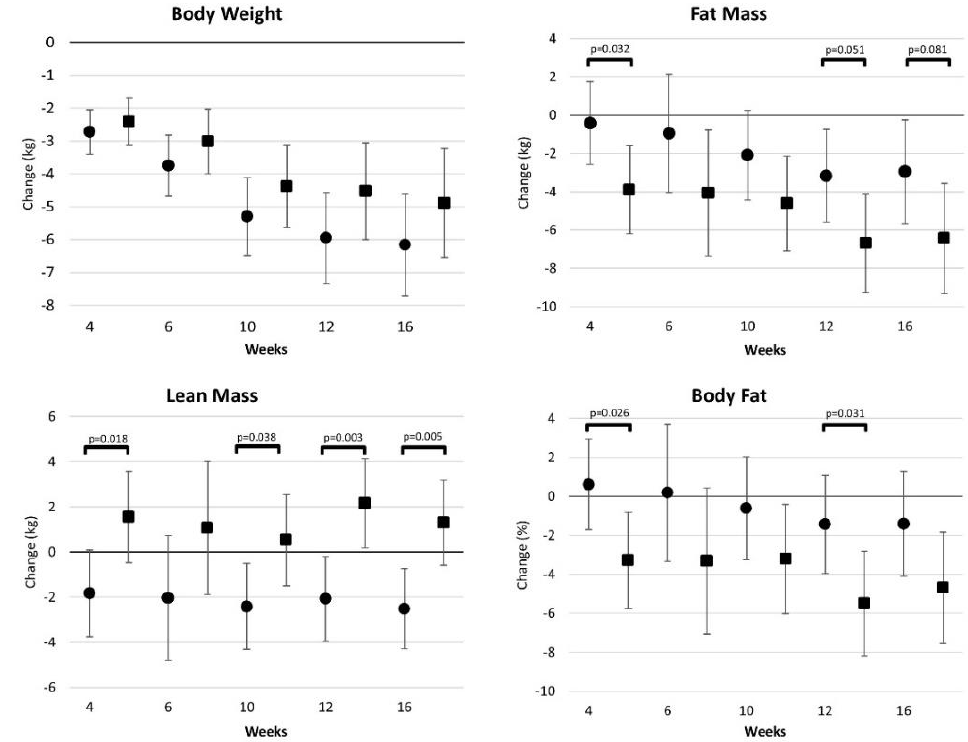
Figure 4. Body composition changes from baseline (mean [95% CI]) observed for Weight Watchers ( • ) and Curves ( ■ ) interventions.